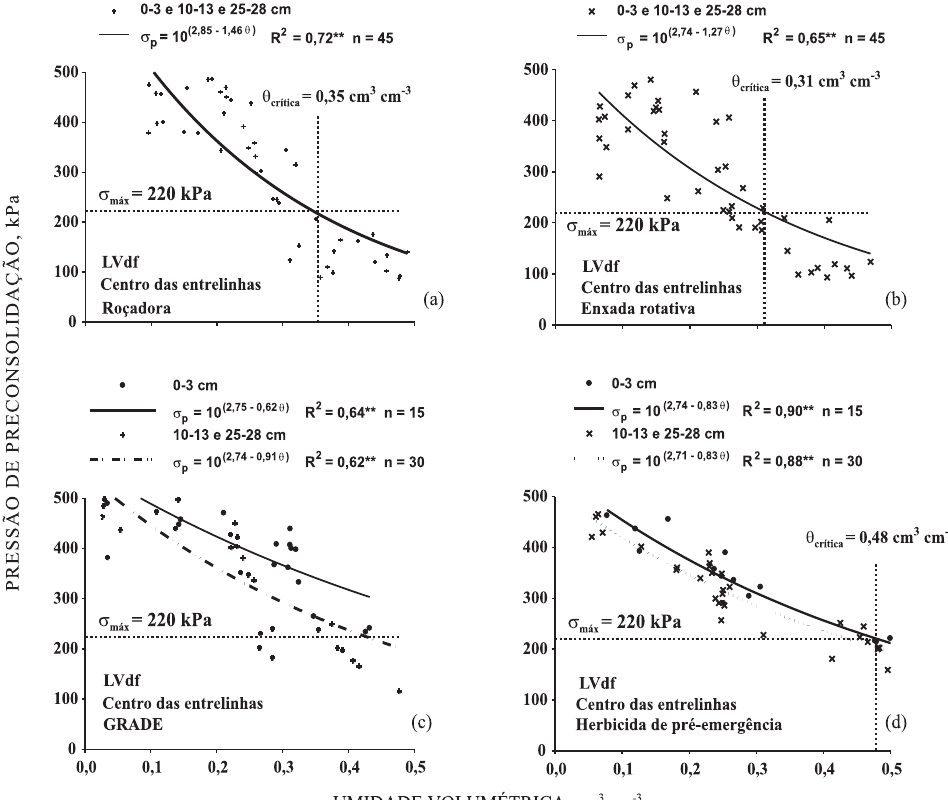
Figura 3. Modelos de capacidade de suporte de carga para um Latossolo Vermelho distroférrico (LVdf) sob mata nativa e cultivado com cafeeiros sob diferentes manejos de plantas invasoras na posição de amostragem centro das entrelinhas dos cafeeiros, em três profundidades. A linha pontilhada horizontal representa a tensão máxima de 220 kPa ( σσσσσ ) aplicada pelo trator utilizado no manejo. As linhas máx pontilhadas verticais representam as umidades críticas ( θθθθθ ) para o tráfego do crítica